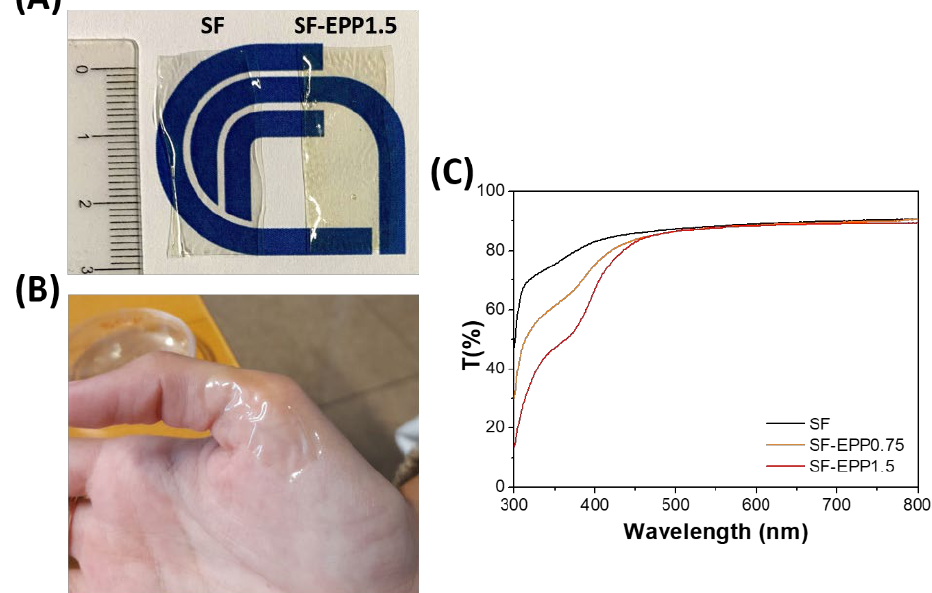
Figure 2. ( A ) Picture of pristine SF and SF-EPP films (1 mL deposited on 1 cm × 3 cm) with the highest EPP content (1.5% vs. SF); ( B ) SF-EPP1.5 adapted to the skin; ( C ) transmittance of SF (black line), SF-EPP0.75 (orange line) and SF-EPP1.5 films (red line).